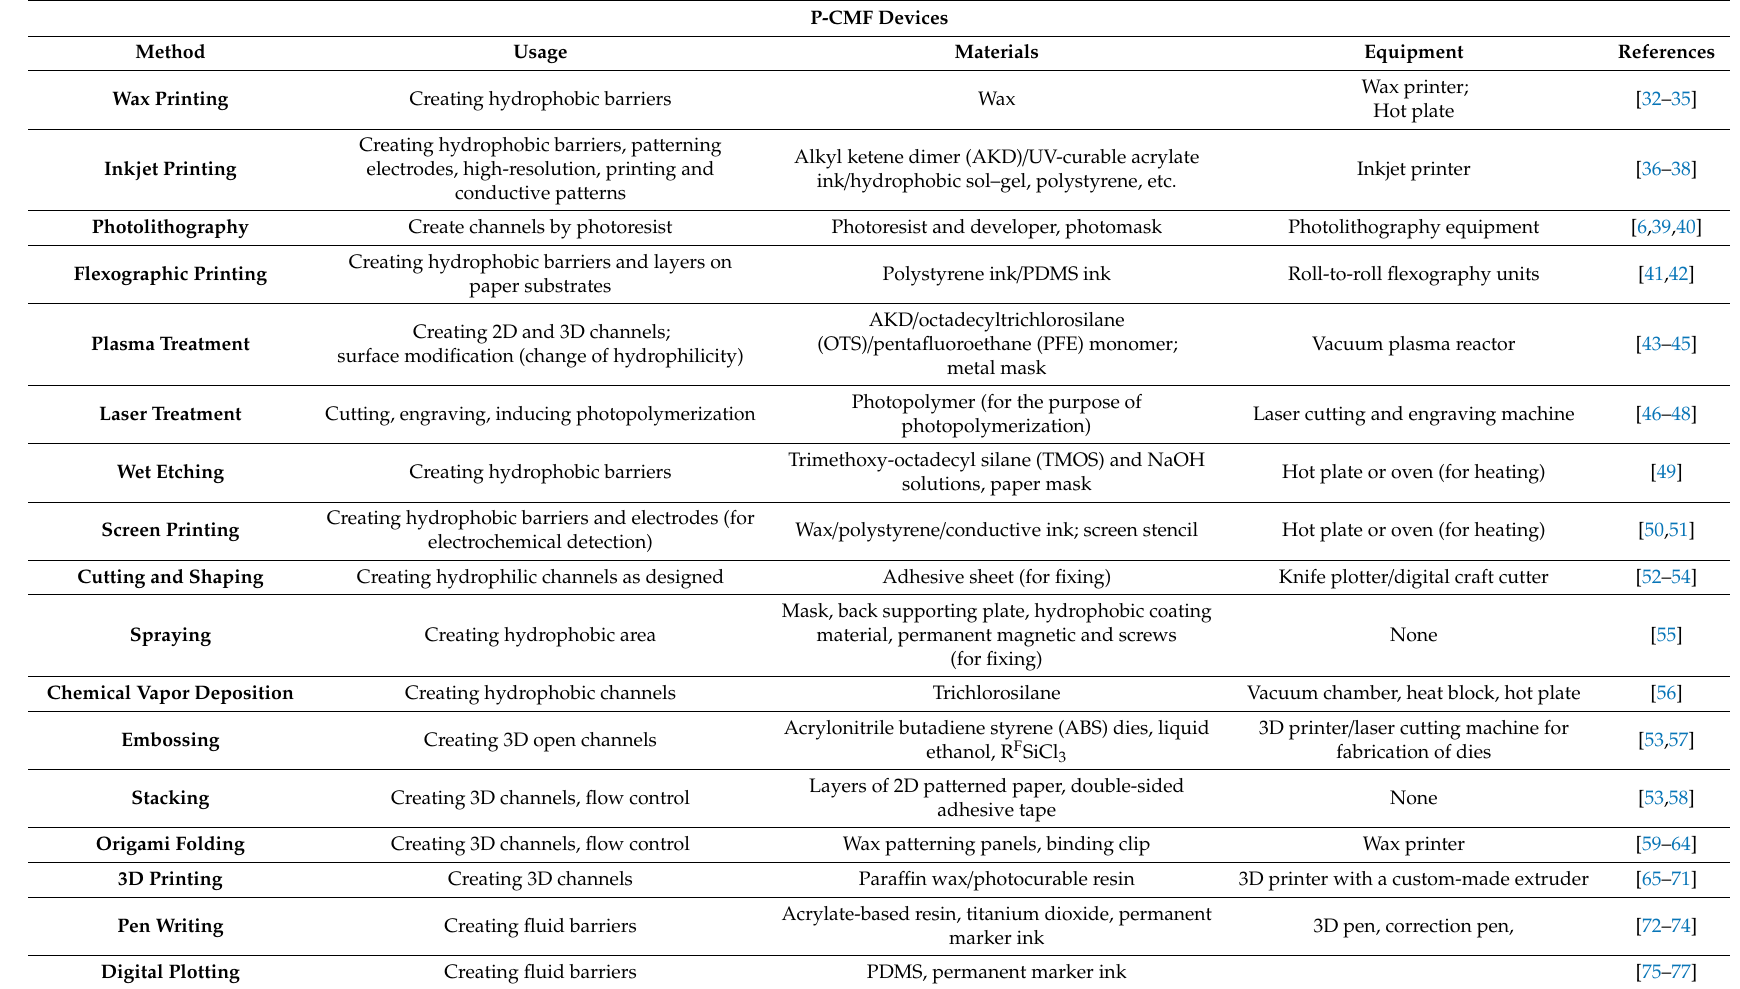
Table 1. Recent fabrication of µ PADs including paper-based continuous-flow microfluidic (p-CMF) and paper-based DMF (p-DMF)